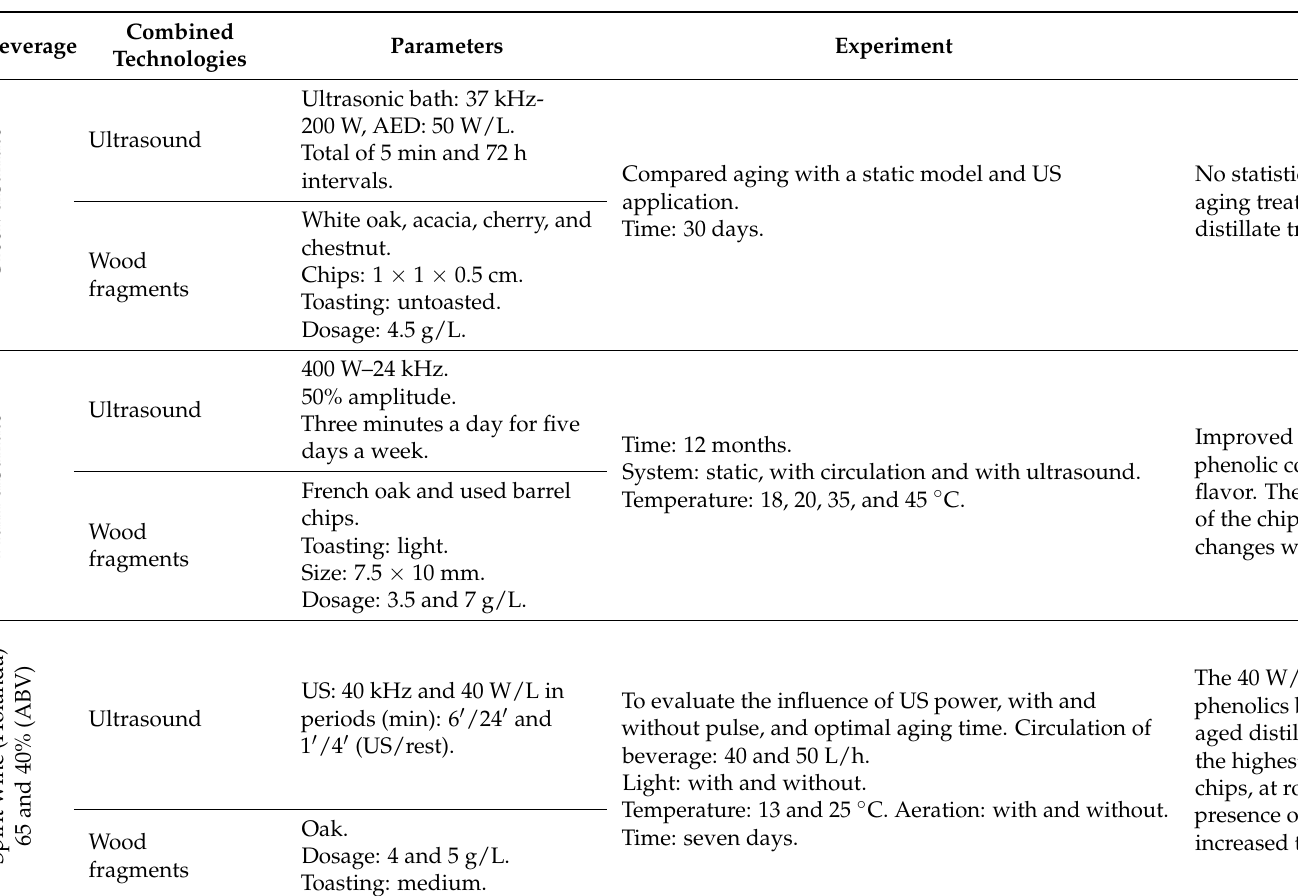
Table 3. Research regarding the application of combined technologies in the aging of